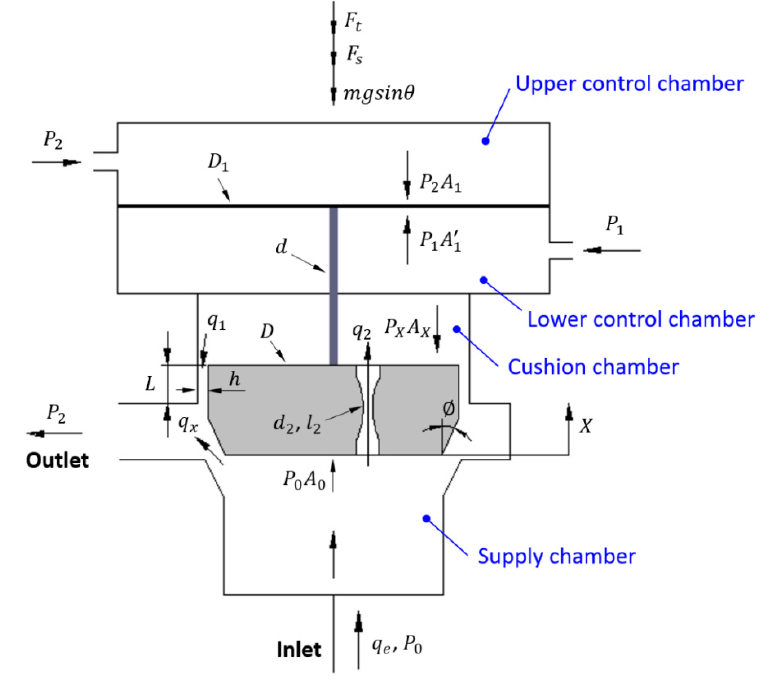
Figure 3. Schematic of forces on the pressure-sustaining diaphragm valve.